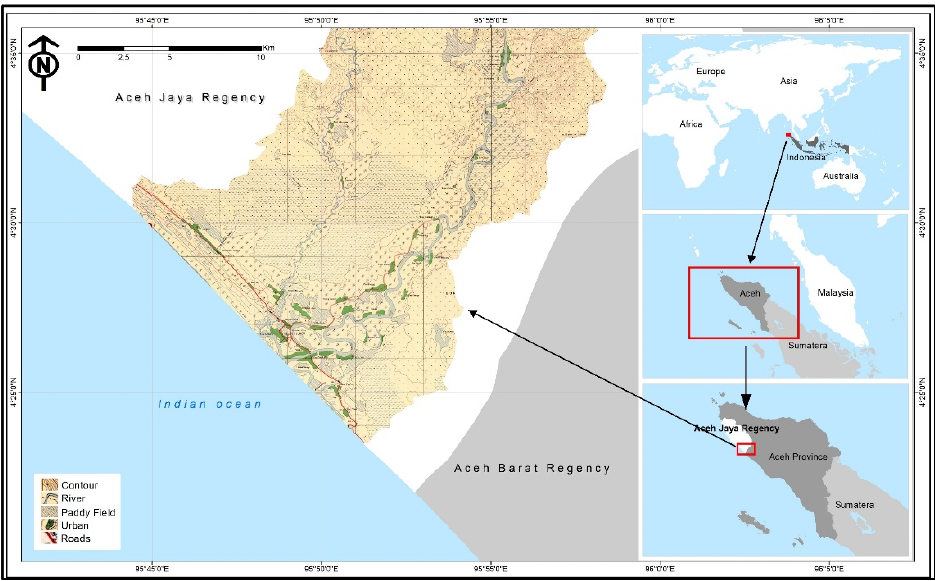
Figure 1. Map of the study area in the Krueng Teunom watershed.